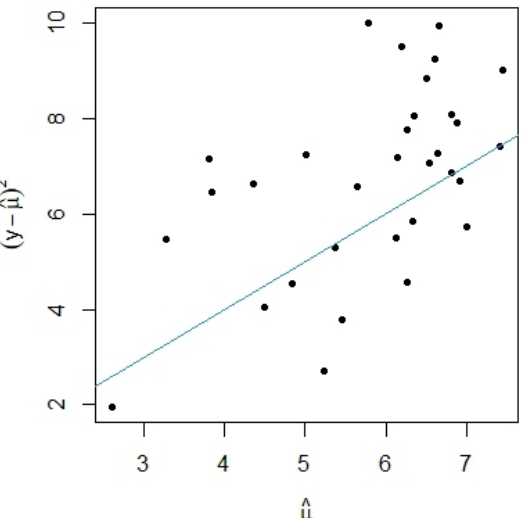
Figure 3. Estimated mean and variance scatterplot for the Poisson results after fitting model (13) to infant mortality rates in